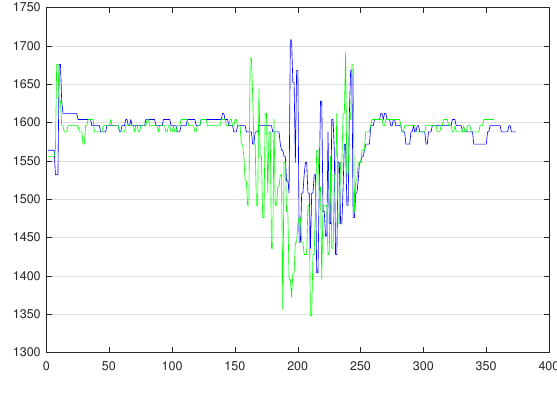
Figure 8. Blue and green time series.